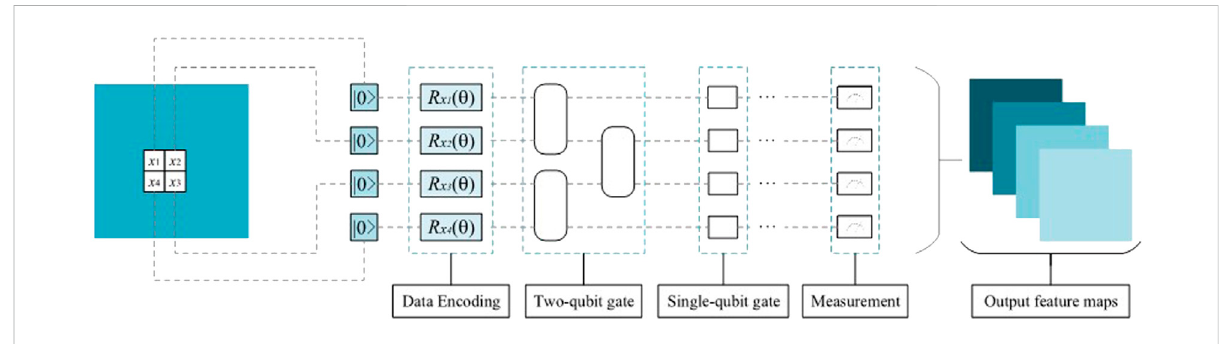
FIGURE 3 Quantum convolution layer.